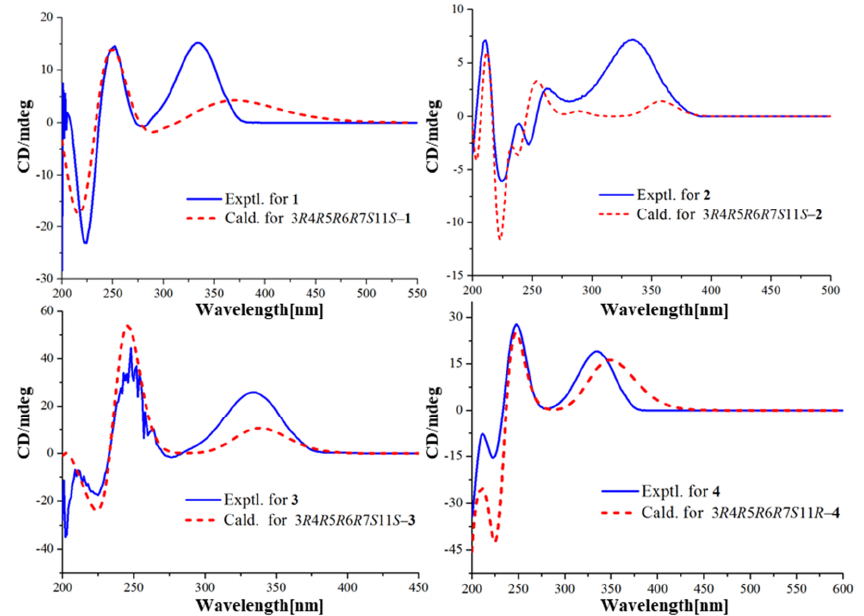
Figure 4. qccNMR coupled with DP4+ probability analysis of compound 1 .